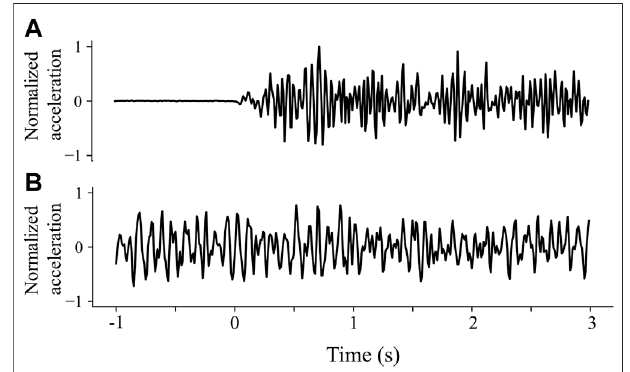
FIGURE 1 | Examples of 4-s waveform data used in this study: (A) a P wave; (B) a microtremor. The point where the abscissa is 0 is the time of the P-wave arrival. The data in Figure 1 have been